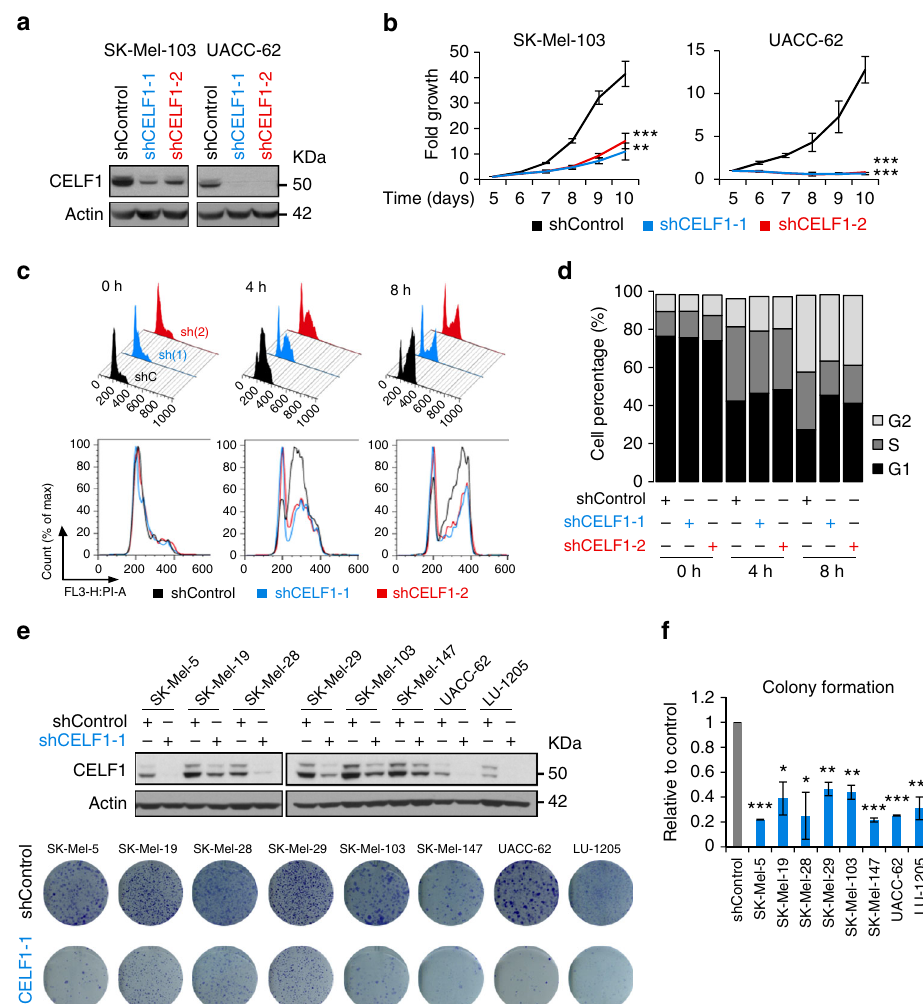
Fig. 2 Cell cycle delay after CELF1 depletion in melanoma cells. a Ef fi ciency of lentiviral-based transfer of CELF1 shRNAs (shCELF1-1 and 2) in the indicated cell lines visualized by immunoblotting with respect to control shRNA. b Impaired growth of SK-Mel-103 and UACC-62 cells upon CELF1 depletion. Time points represent days after lentiviral infection. Error bars correspond to SEM of three independent experiments in triplicate. c Cell cycle pro fi les of shControl and shCELF1 transduced SK-Mel-103 cells at the indicated times after release from thymidine block. d Quanti fi cation of data in c . e Melanoma cells expressing shControl or shCELF1 (upper panel) analyzed for colony formation capability (crystal violet staining) 12 days after cell seeding. f Quanti fi cation of inhibited colony formation of cells as in e . Data are represented as the ratio of inhibition with respect to shControl transduced cells (for simplicity here shown as a gray bar only for SK-Mel-5). Error bars correspond to SEM of two independent experiments in